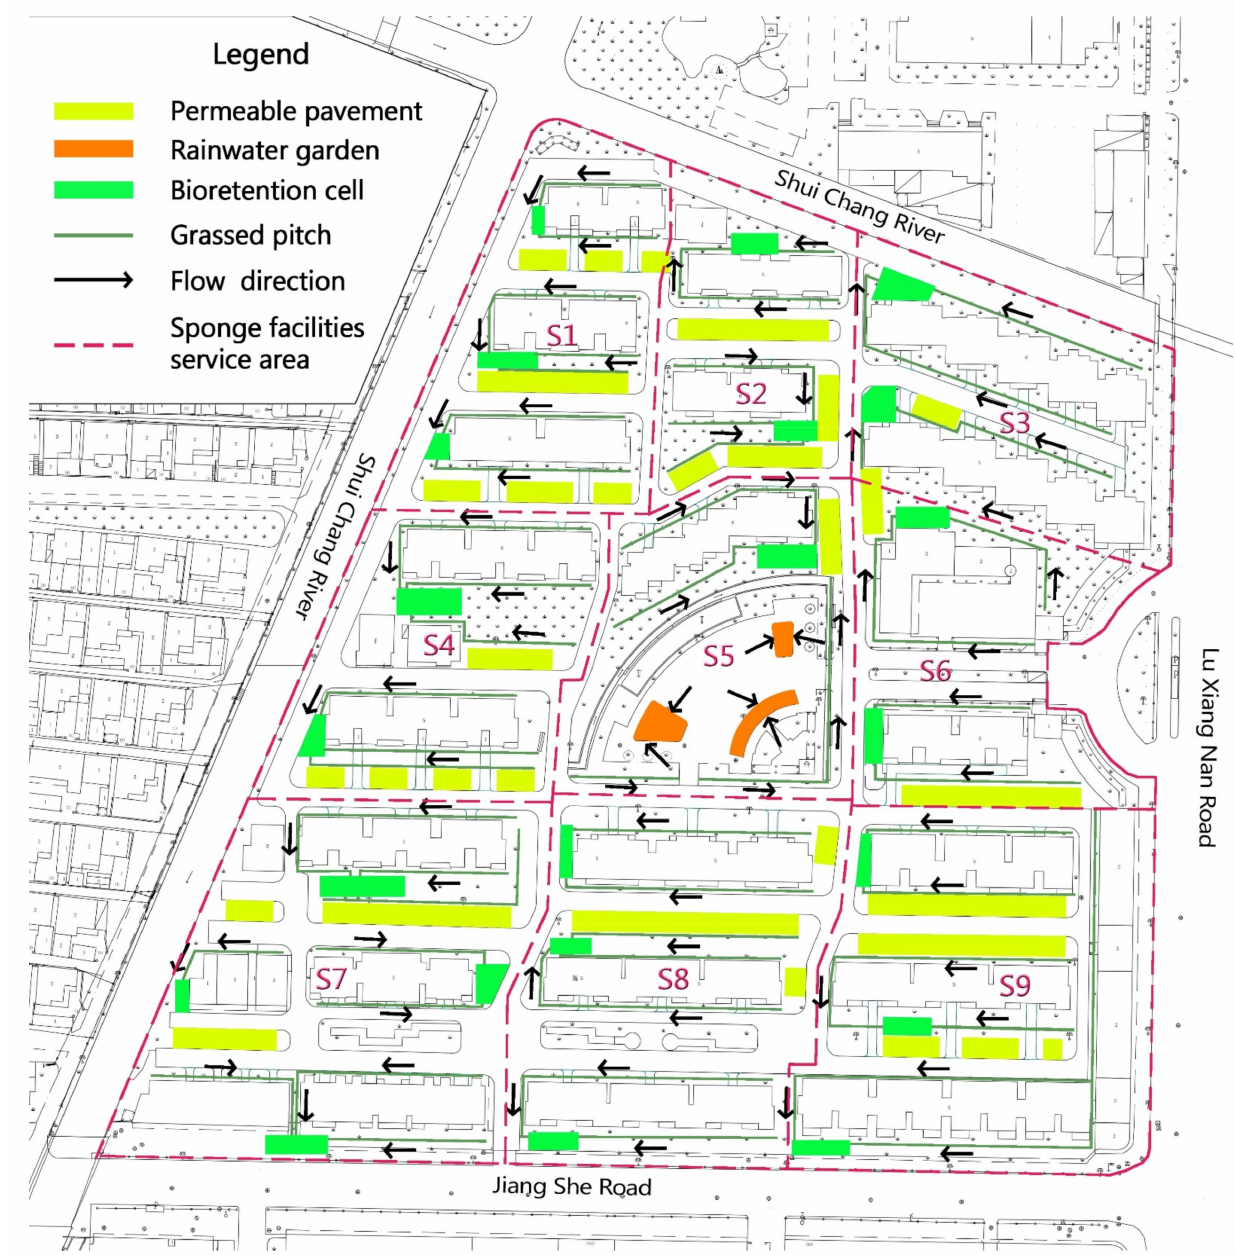
Figure 5. General sponge planning scheme for the Shuixianghuayuan old residential